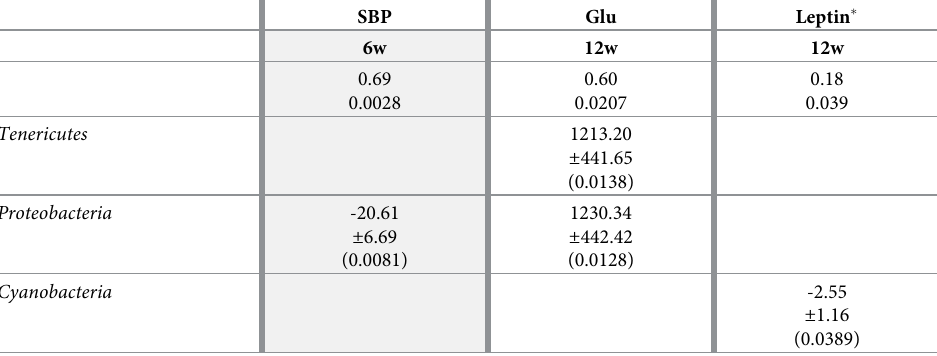
Table 2. Regression fits for each of the physiological variables studied using as independent variables those phyla that show statistical differences in the percentage of sequences retrieved from faecal